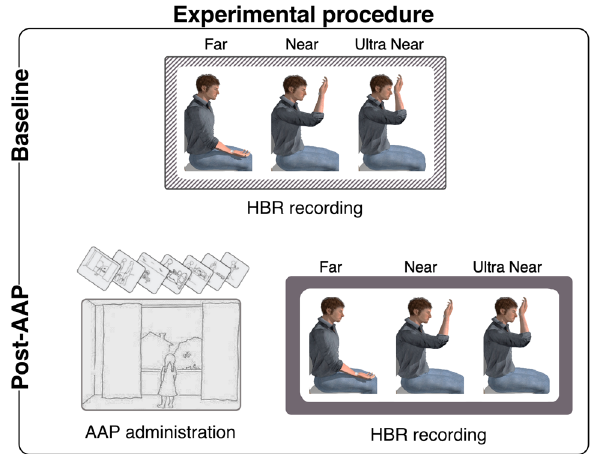
Figure 1. Experimental procedure. Participants underwent HBR recording in two experimental sessions that differed in whether or not they were immediately preceded by the administration of the AAP (Post-AAP session and Baseline, respectively). The images were created with the following software: Matlab R2020b (https:// it. mathw orks. com/ produ cts/ matlab. html) and GraphPad Prism 8 (https:// www. graph pad. com/ scien tific- softw are/ prism/) were used to plot the data. Canvas Draw (https:// www. canva sgfx. com/ produ cts/ canvas- x- draw) was then used to combine all components of the figure into a single panel. The human model has been adapted from a previous study 14